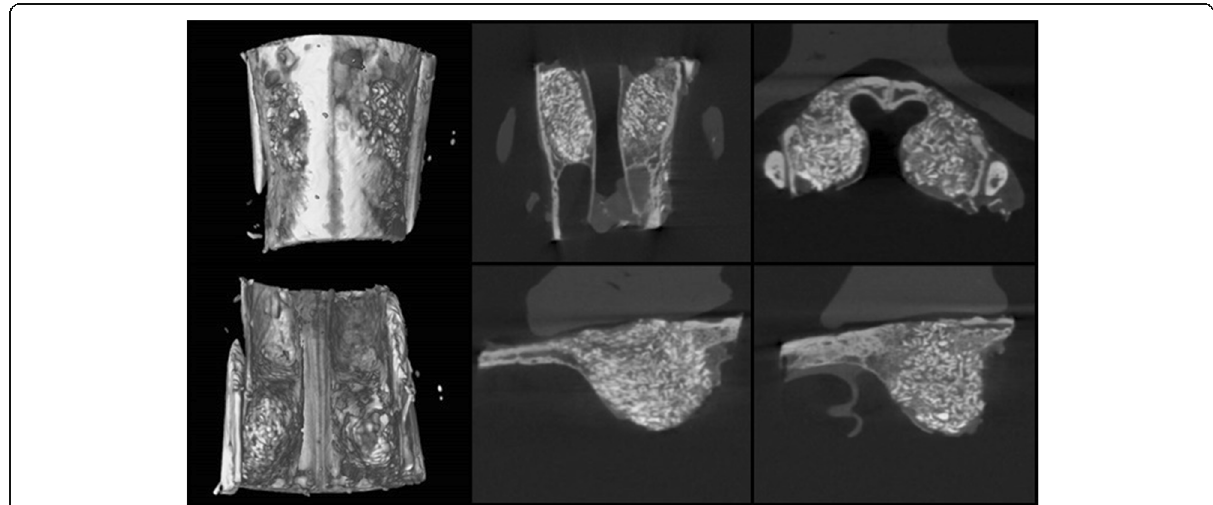
Fig. 4 Micro-CT analysis. a Three-dimensional image. b Axial view. c Coronal view. d Right sagittal view. e Left sagittal view. G 1, group 1, Bio- Oss®; G 2, group 2, Bio-Oss® mixed with Tisseel®